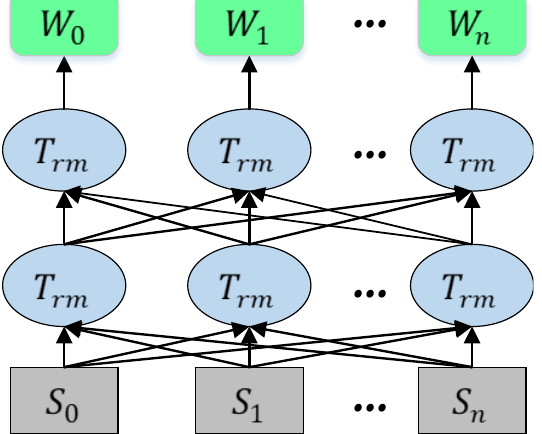
Figure 6. BERT network structure